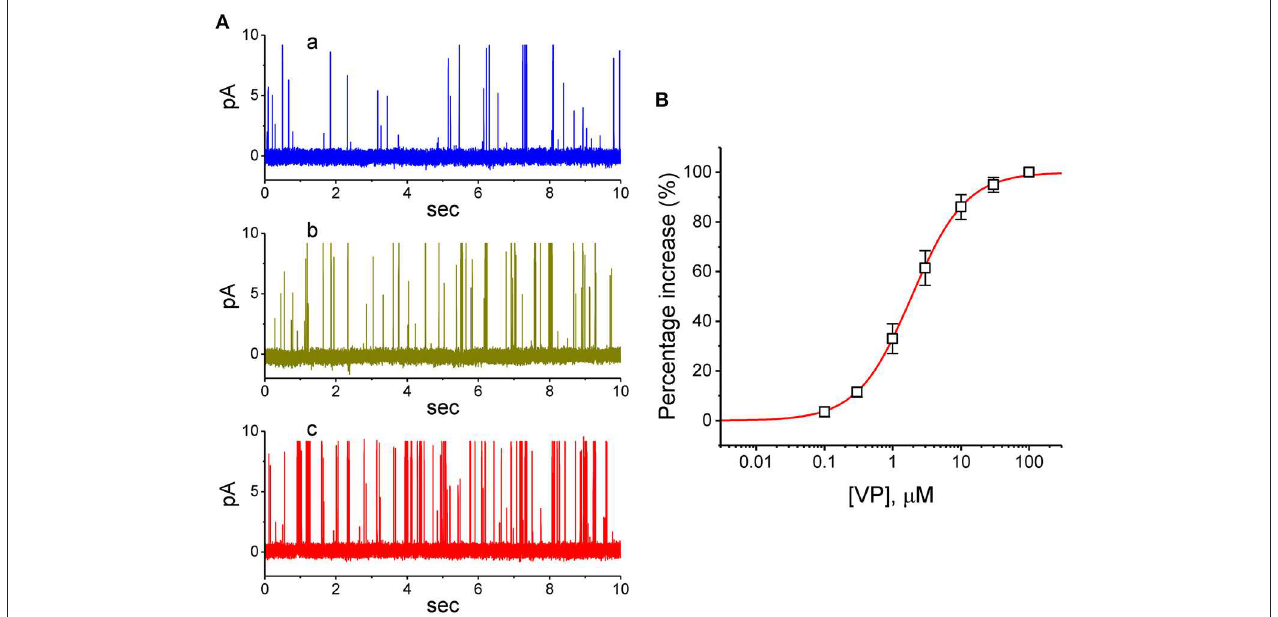
FIGURE 9 | Stimulatory effect of VP on BK Ca -channel activity recorded from human 13-06-MG glioma cells. In this series of experiments, we bathed cells in normal Tyrode’s solution and filled the recording pipette by using high K + -containing solution. (A) Representative BK Ca -channel currents taken under a holding potential of + 60mV relative to the bath. a: control; b: 1 µ M VP; c: 3 µ M VP. (B) Concentration-dependent relationship of VP effect on the probability of BK Ca -channel openings in 13-06-MG cells (mean ± SEM; n = 11 for each point). The examined cell was held at + 60mV relative to the bath, and the channel open probability during the exposure to 100 µ M VP was taken to be 100%. The smooth line represents the least-squares fit of the data points to the sigmoidal Hill equation as described in Materials and Methods . The values of EC 50 , Hill coefficient, and maximal percentage increase of channel activity were estimated to be 1.9 µ M, 1.1, and 100%,